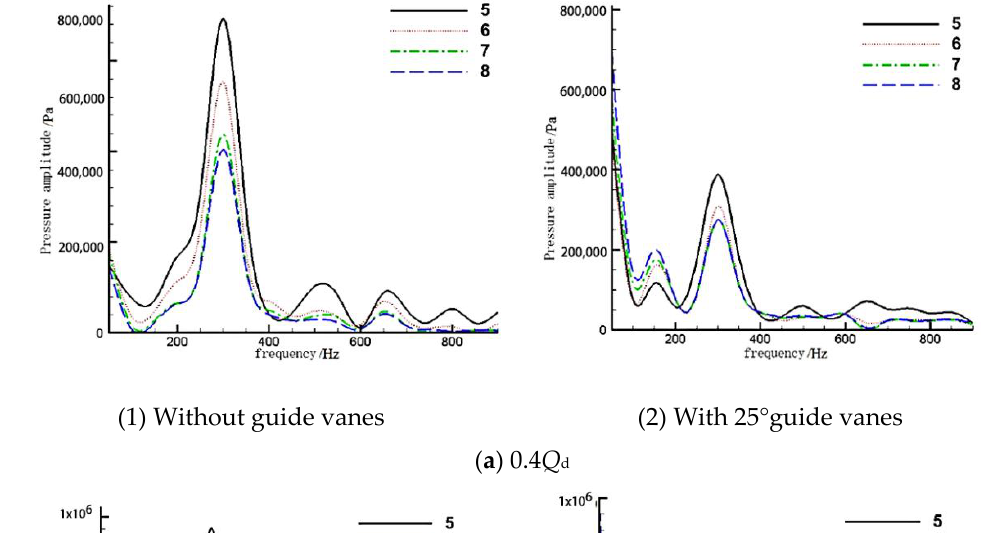
Figure 15. Frequency domain diagram of pressure pulsation in Section VI for different flow rates: ( a )